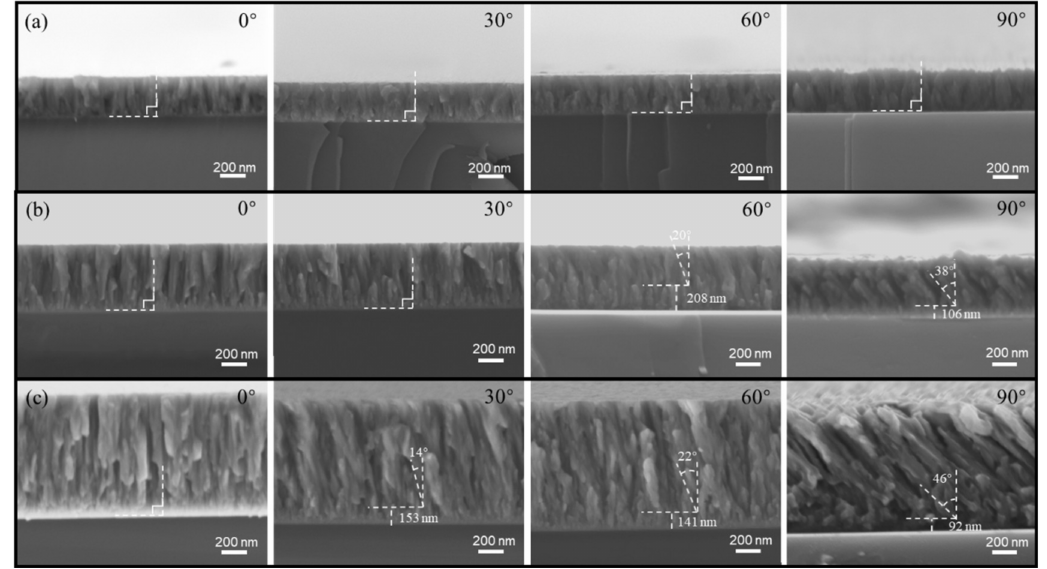
Figure 2. Cross-sectional morphology of Ti films deposited on Si substrates with film thicknesses of 300 nm ( a ), 500 nm ( b ), and 1000 nm ( c ).